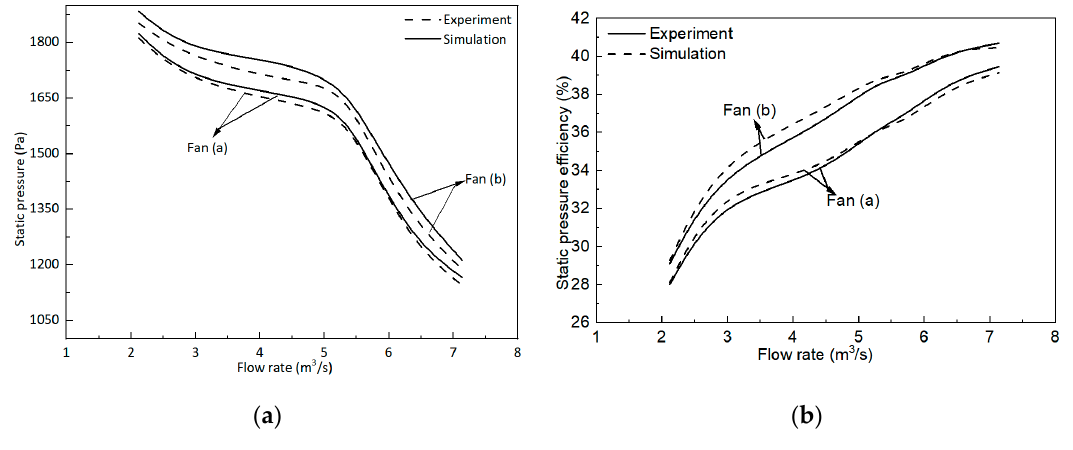
Figure 5. Calculated curves. ( a ) p sp ; ( b ) η sp